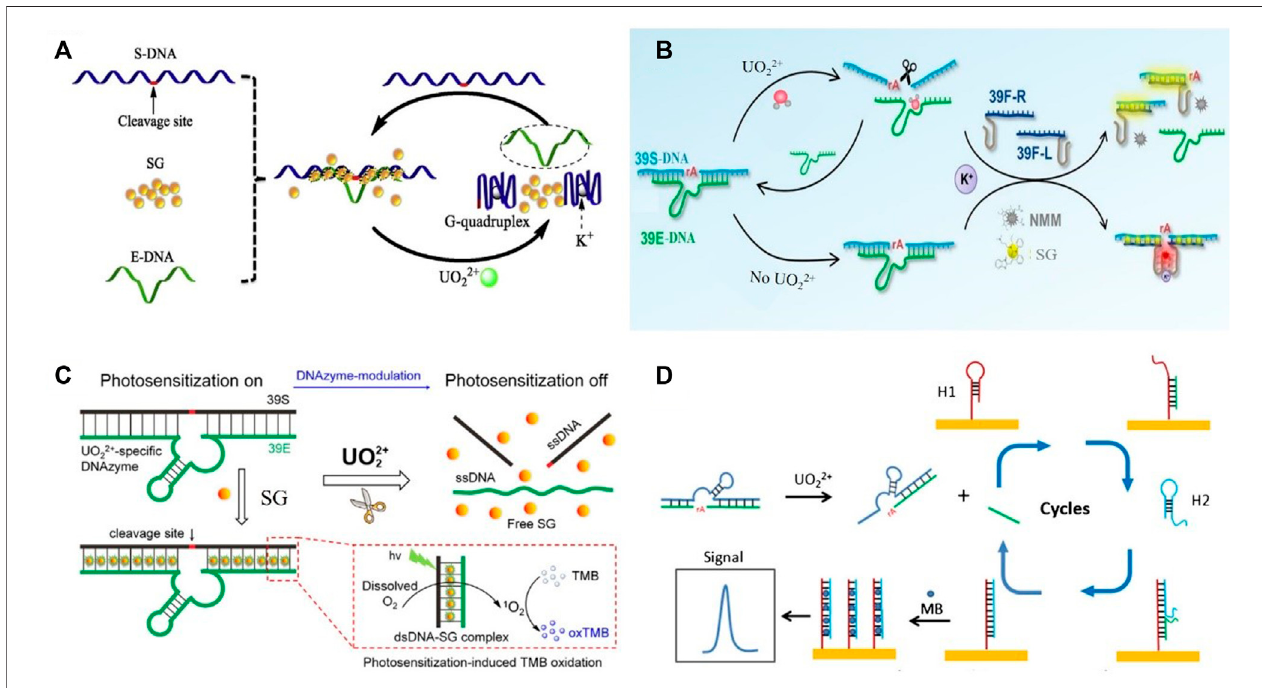
FIGURE 1 | DNAzyme-based biosensors for the detection of uranyl ions by integrating with diverse signal outputting strategies in previous reports (A) G-quadruplex-assisted enzyme strand recycling-based fl uorescent uranyl ion sensor. Reprinted with permission (Zhu et al., 2019), Copyright 2019 Elsevier B.V. (B) Ratiometric fl uorescent biosensor for uranyl detection. Reprinted with permission (Yang et al., 2021). Copyright 2021 Elsevier B.V. (C) Electrochemical biosensor for uranyl detection based on DNAzyme and CHA. Reprinted with permission (Yun et al., 2016a). Copyright 2017, Royal Society of Chemistry (D) DNAzyme- modulated SG photosensitization colorimetric sensor for detection of UO 22+ . Reprinted with permission (Huang et al., 2018). Copyright 2017, Royal Society of Chemistry.